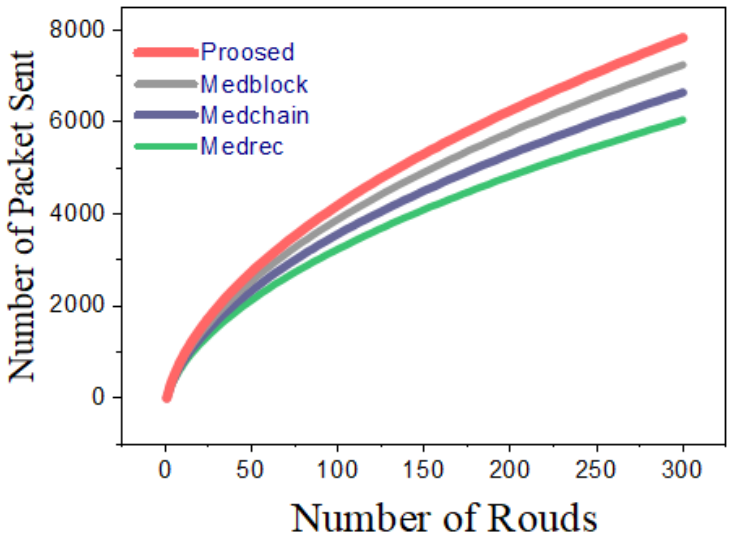
Figure 20. Comparative analysis of the proposed access control policies and the benchmark models (number of rounds versus packets sent) [49–51].